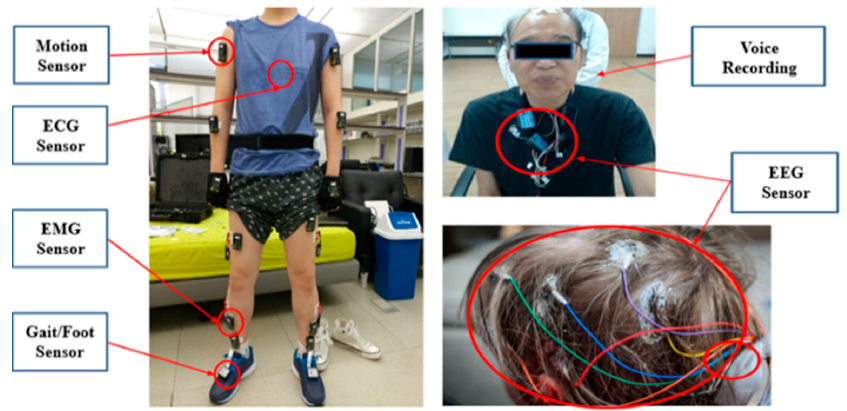
Figure 2. Sensor specific location attachment for collecting multiple bio-signals.